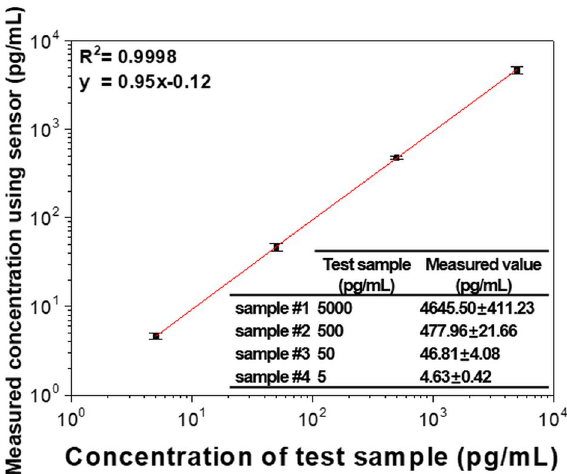
Figure 6. Estimation of Tg in the test samples with concentrations unknown to the tester.